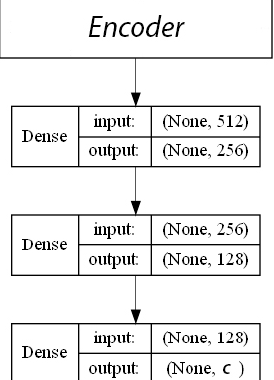
Figure A4. The optimal determined topology and hyper-parameters of a simple FFNN in combination with encoders. The notation c was set to 10 and 1 in tasks No. 1 and No. 2, respectively.